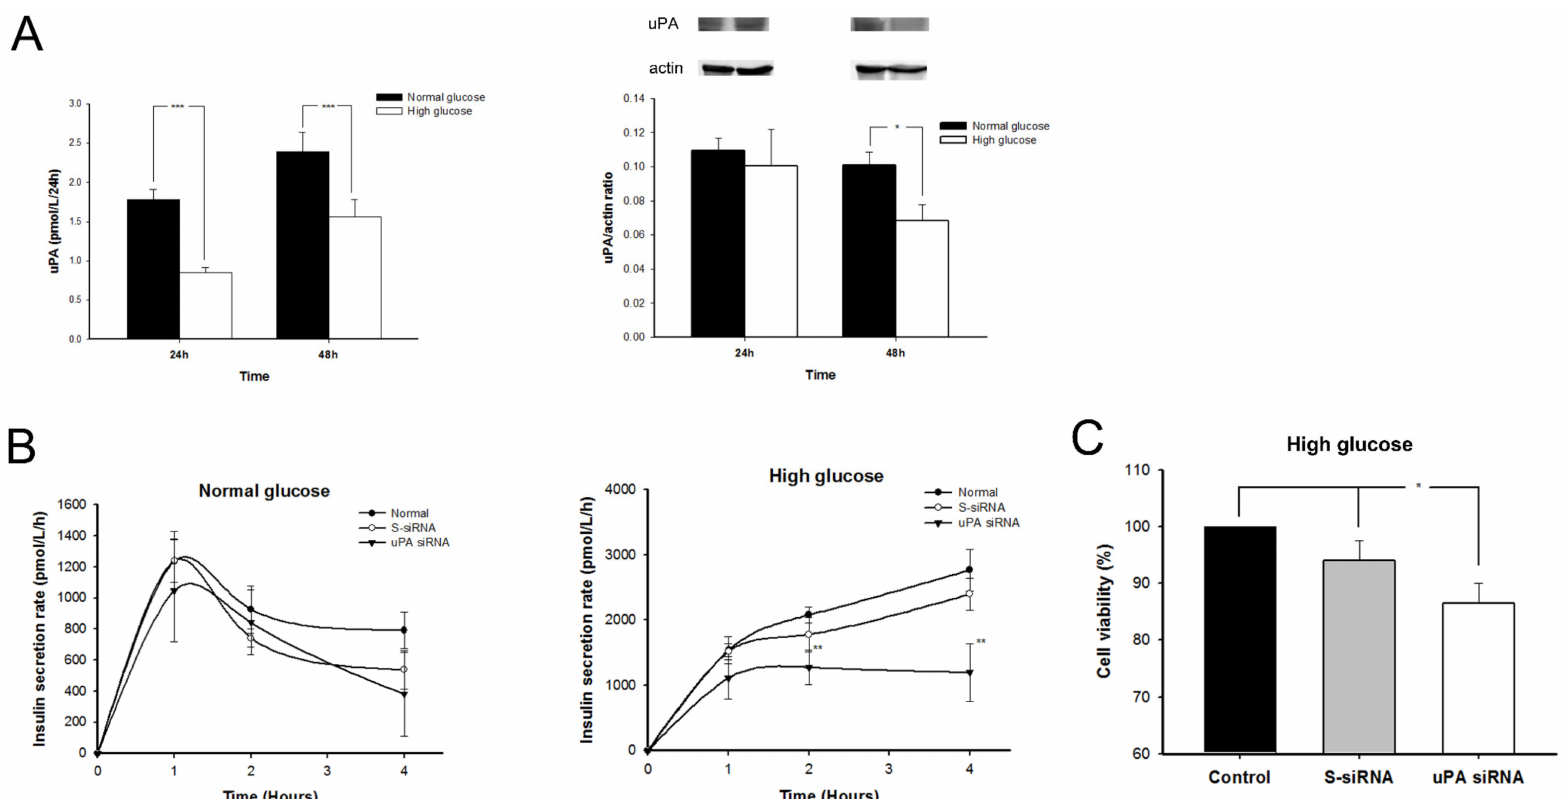
Figure 4. The ( A ) uPA secretion rate and expression on β cells; ( B ) insulin secretion rate, in normal glucose or high glucose; and ( C ) β cell proliferation in high glucose (n = 6). (A) The uPA secretion rate of β cells in normal glucose (black bar) was significantly faster than those in high glucose (white bar) treated for both 24 and 48 h. *** p < 0.001. The uPA expression on β cells significantly declined after treatment with high glucose for 48 h. * p < 0.05 (Mann–Whitney U test) (B) The insulin secretion rate in normal glucose showed no significant di ff erence among control (black circle), S-siRNA (blank circle) or uPA siRNA (inversed triangle) groups. After silencing uPA by siRNA, the insulin secretion rate of β cells decelerated significantly in high glucose. ** p < 0.01. (Kruskal–Wallis H test) (C) β cell proliferation is evaluated by MTT assay while incubated in high glucose for 48 h. After silencing uPA expression by siRNA (white bar), the β cell proliferation significantly decreased in high glucose as compared with control (black bar) and S-siRNA groups (gray bar). * p < 0.05 (Kruskal–Wallis H